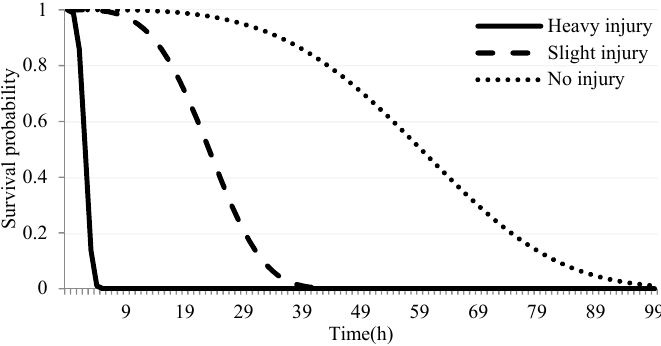
Figure 4. The deterioration rate of survival probabilities of victims with different injury severity.